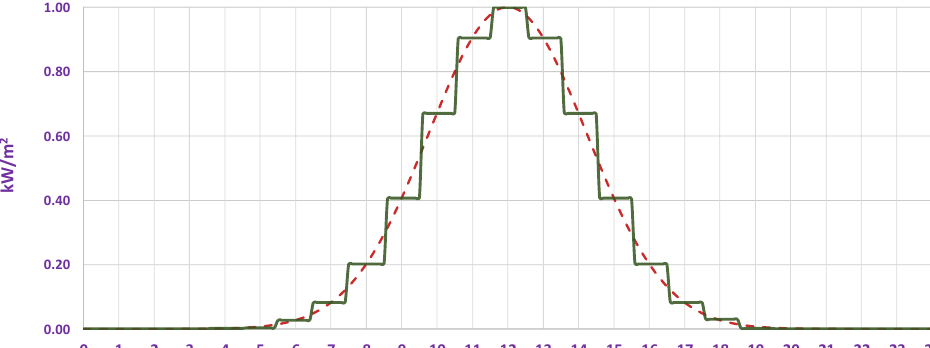
Figure 3. Solar power density, continuous, and discretized model.